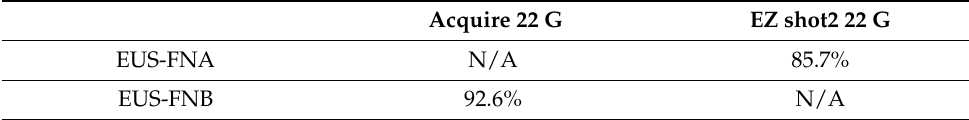
Table 8. Sensitivity, specificity, accuracy of EUS-FNA vs.